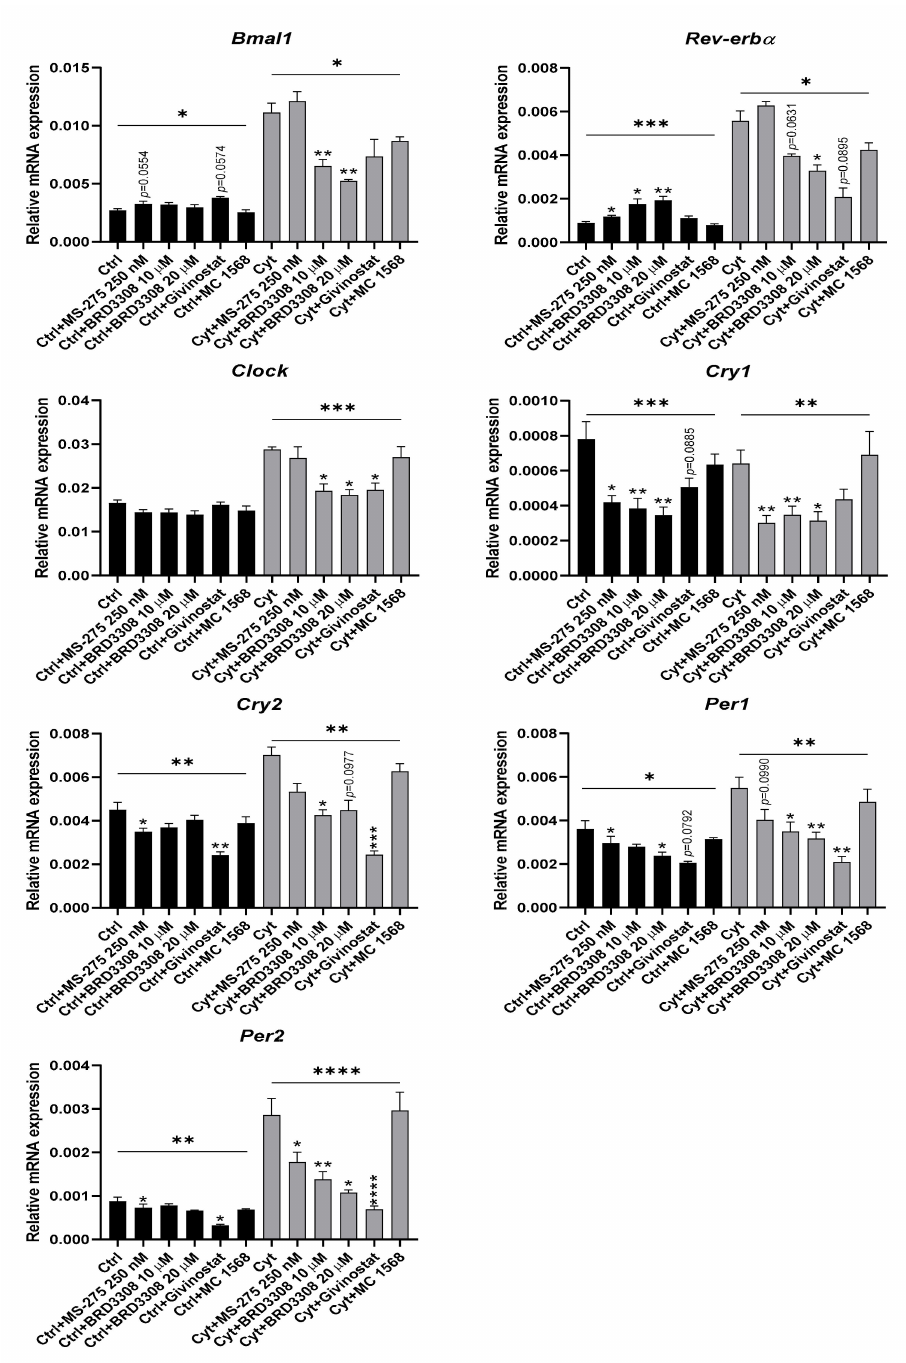
Figure 7. Lysine deacetylase (KDAC) inhibition reduces cytokine-mediated changes in clock gene expression in non- synchronized INS-1 cells. INS-1 cells were treated with 250 nM MS-275, 10 or 20 µ M BRD3308, 150 nM givinostat, or 2 µ M MC-1568 for 1 h pre-incubation followed by 12 h co-incubation with or without 150 pg/mL mouse IL-1 β + 0.1 ng/mL rat IFN- γ (Cyt). Relative mRNA expression is calculated using peptidylprolyl isomerase A ( Ppia ) as reference gene. Values are means ± SEM ( n = 4). Statistics are one-way ANOVA with p -values represented by symbols above the line and with Dunnett’s corrected multiple comparisons to Ctrl (black bars) or to Cyt (gray bars). Significance levels were annotated as follows: * = p -value < 0.05, ** = p -value < 0.01, *** = p -value < 0.001, **** = p -value <